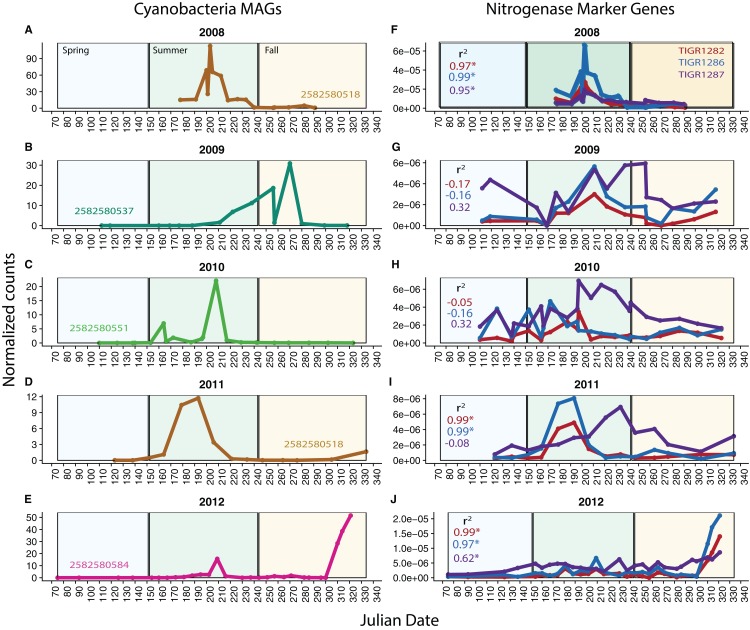
Cyanobacteria and nitrogen fixation over time.To investigate potential functional changes over time in Mendota, we compared the abundances of Cyanobacteria MAGs (approximated using read coverage normalized by genome length) to the abundances of nitrogen fixation marker genes (approximated using the number of BLAST hits to metagenomes normalized by metagenome size). Only the most abundant Cyanobacteria MAG is shown for each year (A–E) because a single MAG was much more abundant than the rest in each year. The marker genes used were TIGR1282, TIGR1286, and TIGR1287, encoding subunits of Mo–Fe nitrogenase, as these were the most frequently observed nitrogenase markers in the Mendota metagenomes (F–J). Significantly correlated trends over time were observed between the MAGs and the nitrogenase marker genes in 2008, 2011, and 2012. In years where there was no significant correlation, the dominant MAG did not contain genes indicative of the nitrogen fixation pathway. This suggests that Cyanobacteria dynamics may be linked to the potential for nitrogen fixation in Mendota.